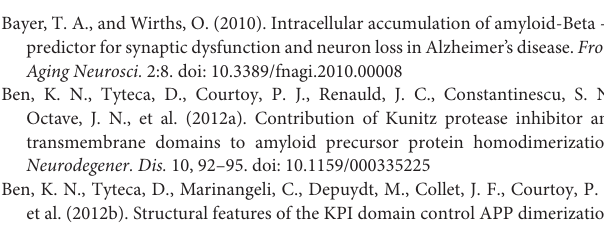
FIGURE S1 |Expression of C40 and C42 mA do not lead to A β oligomers formation. Cells were transfected with the control empty vector (mock), or constructs expressing C42 or C40. (A) Analysis of C42/C40 expression and A β oligomerization was monitored in cell lysates by Western blotting with the W0-2 antibody. Oligomers ( ∗ ) are indicated by arrows. (B) Expression of C42 and C40 mRNA levels were measured by RTqPCR with the same primers and given as percentage of mRNA levels measured in C42-expressing cells. FIGURE S2 | Mass spectrometry analysis of the oligomeric bands produced in C42-expressing cells. Cell lysates from non-transfected (mock) and C42 transfected cell were separated on NuPage gradient gels in denaturating conditions. Gel bands around 30 kDa were excised and proteins were extracted and digested with trypsin. Following digestion, purified peptide samples were analyzed by nanoLC coupled to tandem mass spectrometry (MS/MS). The raw MS file were analyzed and searched against the APP protein sequence database. The results summarized showed the high confidence identification of two peptide sequences contained in the C42/A β 42 peptides. C42 and A β 42 sequences are given on the top of the tables. Peptide sequences identified are in bold. Signal peptide sequence is in blue. FIGURE S3 | Resistance of A β oligomers to temperature. Media of cells expressing C42 or C42m5 were collected and heated at 95 ◦ C for 0, 10 to 30 min prior to Western blotting revealed with the W0-2 antibody. Oligomers ( ∗ ) are indicated by an arrow. FIGURE S4 | A β oligomers formation in cells expressing different C-terminal truncations of C99. (A) Schematic representation of the different constructs. C99 corresponds to the APP β C-terminal fragment. Numbering corresponds to aminoacid position in the C99 sequence. C55, C49, and C42 have been generated by entering a stop codon at positions 55, 49, and 42 of C99, respectively. TM, Transmembrane region; ext, extracellular; int, intracellular. The aminoacid substitution (referred to as m5) generated for each construct appears in bold and red. (B) Expression of C99, C99 m5, C45 m5, C49 m5, and C55 m5 in CHO cells analyzed by Western blotting with the W0-2 antibody. Oligomers ( ∗ ) and monomers are indicated by arrows. (C) A β 38, 40, and 42 were quantified by ECLIA in the culture media of transfected cells. Values (means ± SEM) given in pg/ml are representative of three independent experiments ( n = 3 in each experiment). ∗ p < 0.05, ∗∗∗ p < 0.001, as compared to control cells (mock-transfected